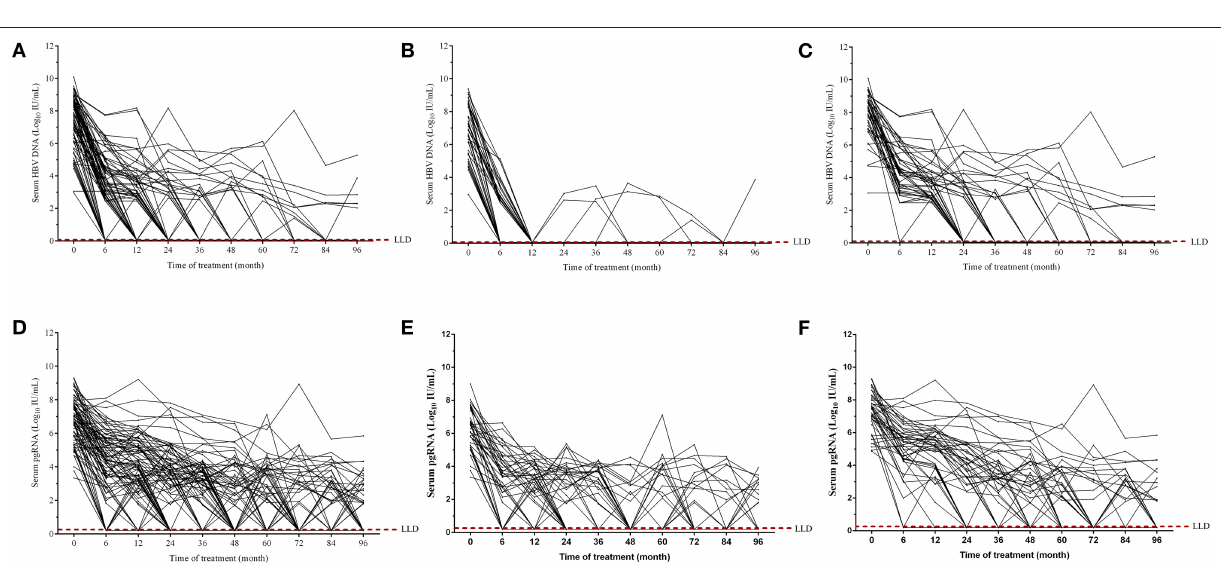
7.64 log10 IU/mL ( Figure 5C ), indicating that baseline serum pgRNA may be a potential biomarker for predicting HBeAg seroconversion in patients with regular long-term NAs therapy. However, the baseline serum pgRNA may not be associated with the change of HBsAg levels. At the end of our observation, total of 83 patients achieved negative HBV DNA.